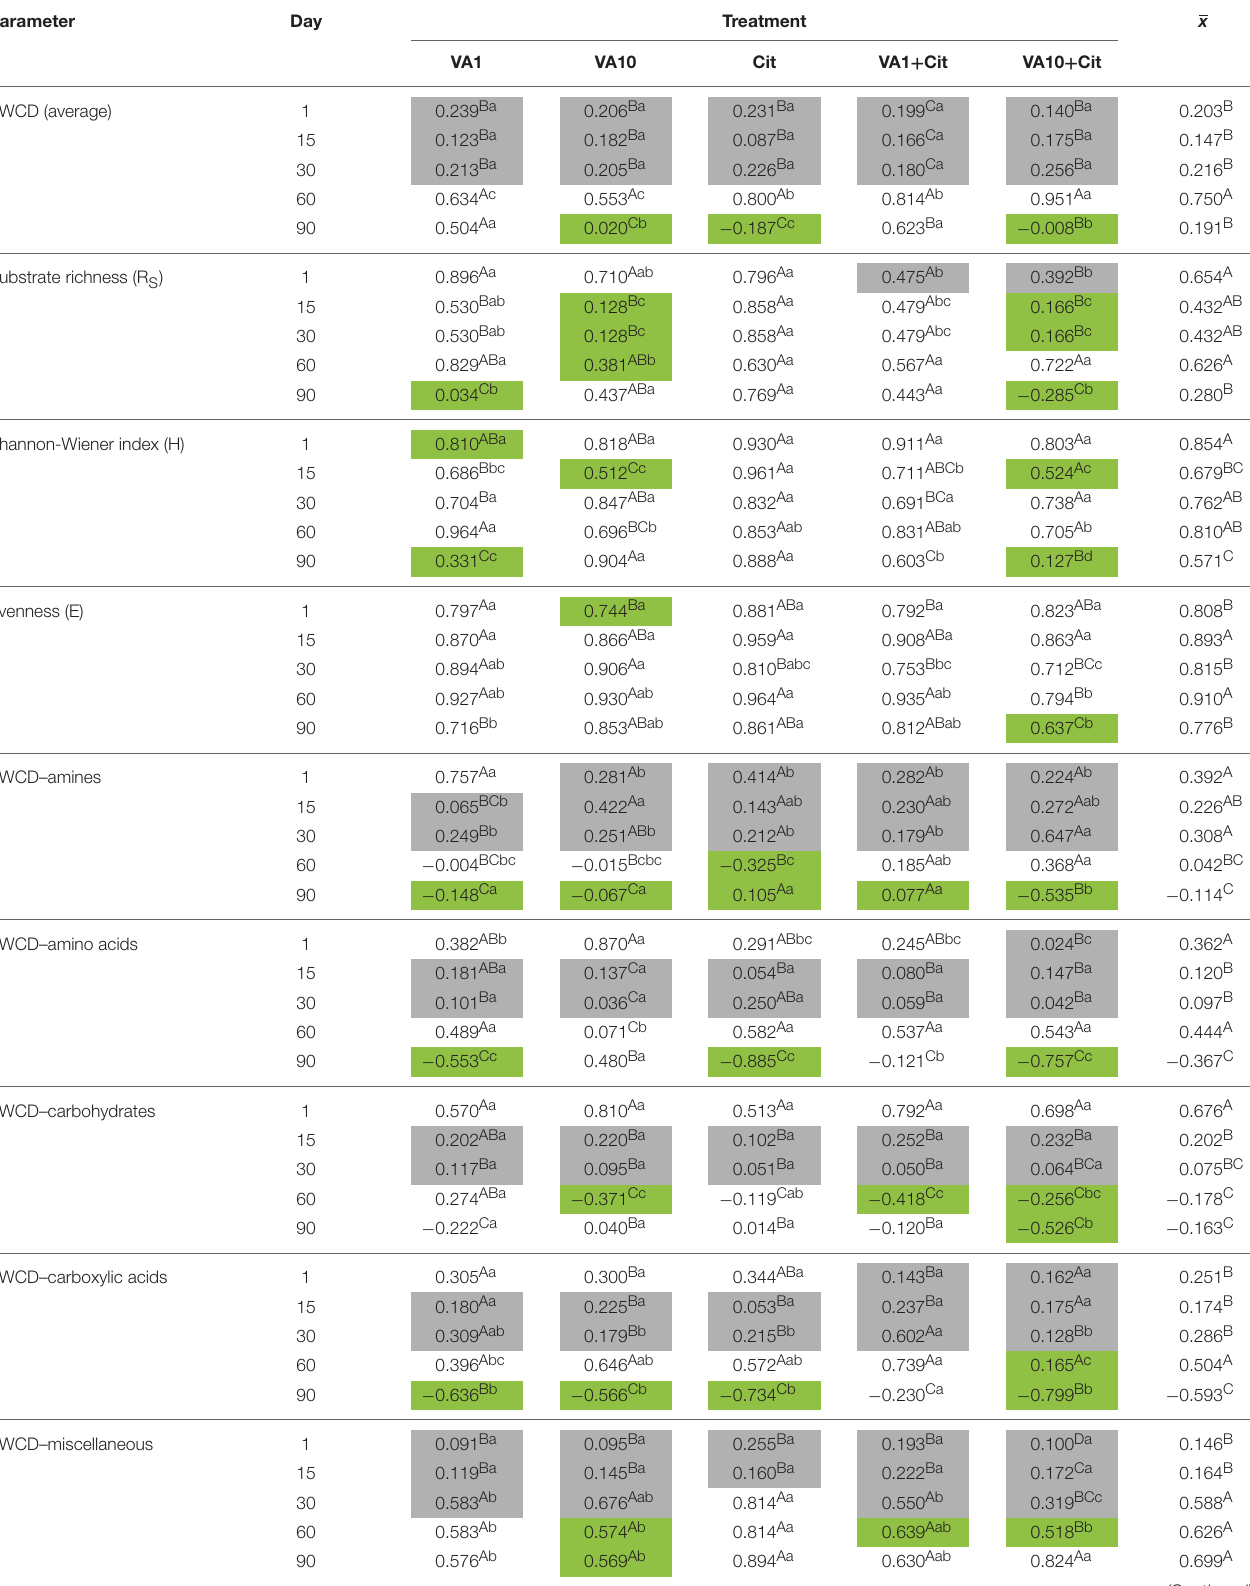
TABLE 1 | Values of the resistance (RS) index for measured parameters obtained for each day of the experiment. Parameter